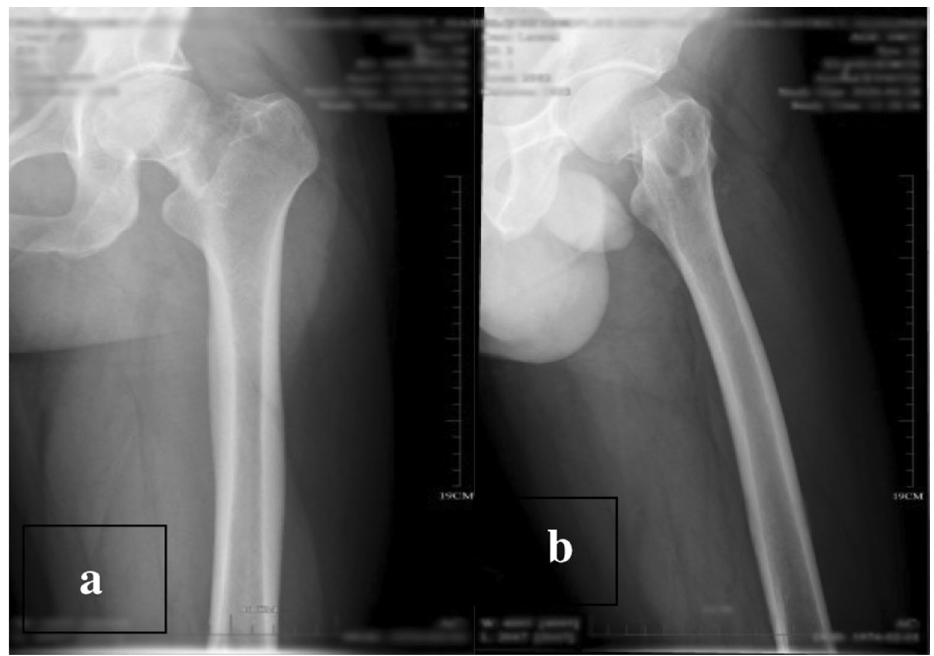
Figure 12. ( a , b ) The positive side radiographs of the injured side of the patient at the time of admission ( Note : The patient was a 47-year-old male. He was admitted to the hospital for 2 h due to a high fall